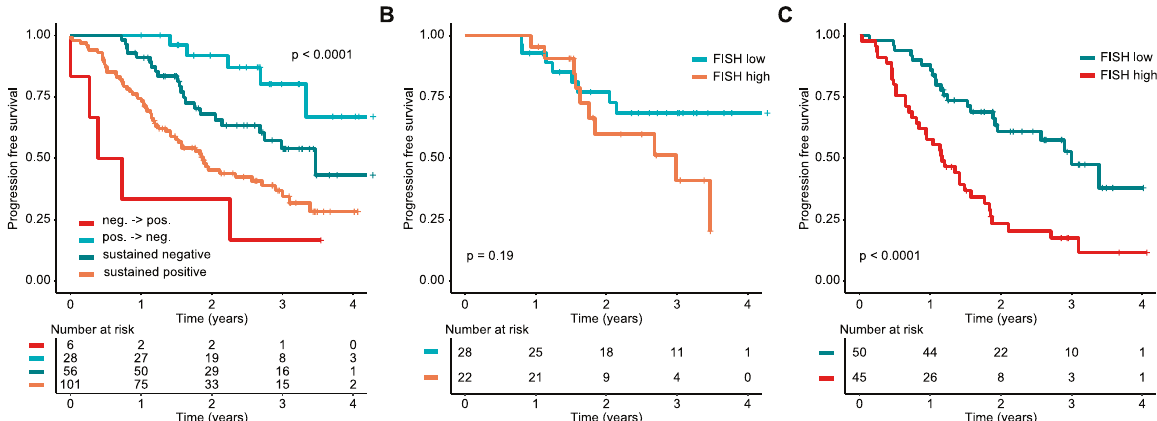
Fig. 5 The impact of sequential mass spectrometry on PFS and the combination with the cytogenetic risk status. A PFS landmark analysis from 1 year (±3 months) of maintenance/observation. Patients were grouped according to the combination of the two mass spectrometry (MS) test results at the start of maintenance treatment/observation and after 1 year (±3 months) of maintenance treatment/observation. Four groups were discriminated against: sustained negativity (both MS tests negative), sustained positivity (both MS tests positive) as well as conversion from positivity to negativity (MS test positive -> negative) or vice versa (MS test negative -> positive). In ( B ) and ( C ) sustained MS negative and positive patients were further strati fi ed by the baseline FISH risk status, respectively. High-risk cytogenetics were de fi ned by the presence of t(4;14), t(14;16), del(17p) and/or gain(1q21).